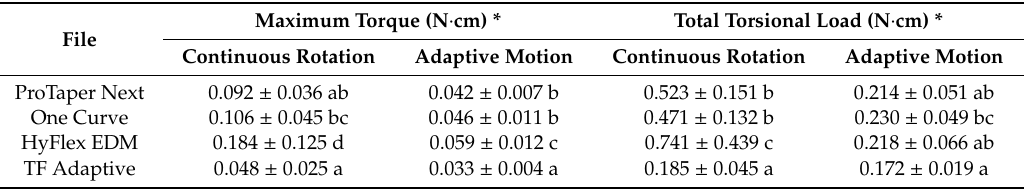
Figure 2. Representative torsional load generation during the adaptive motion (blue) and continuous rotation (orange) for One Curve system: ( a ) ProTaper Next; ( b ) One Curve; ( c ) HyFlex EDM; ( d ) TF Adaptive. Table 2. Maximum torque (N · cm) and total torque (N · cm) according to the kinetic motion and file systems.